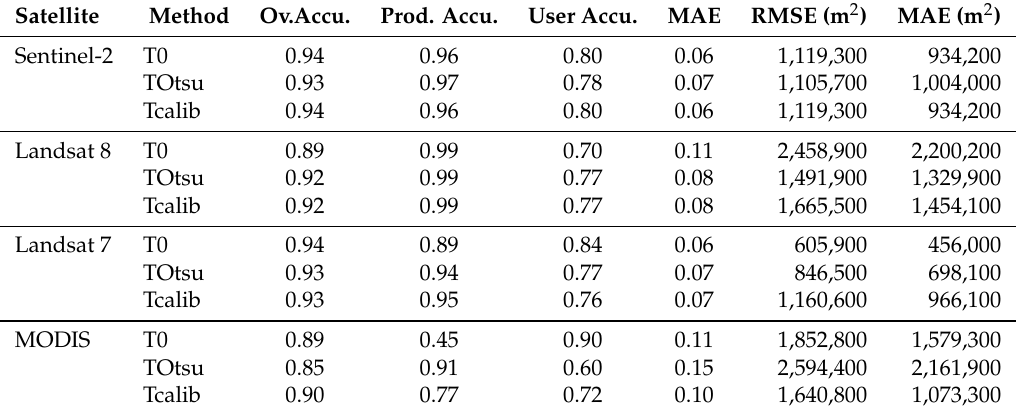
Table 5. Average accuracy and error metrics for three MNDWI classification methods on single sensor imagery over the 2017 and 2019